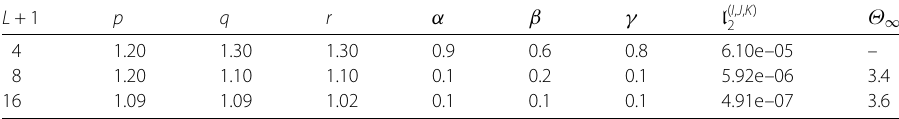
Table 3b Errors and computational rate for the EF-EEG-TOCS in Example 5.3 L + 1 p